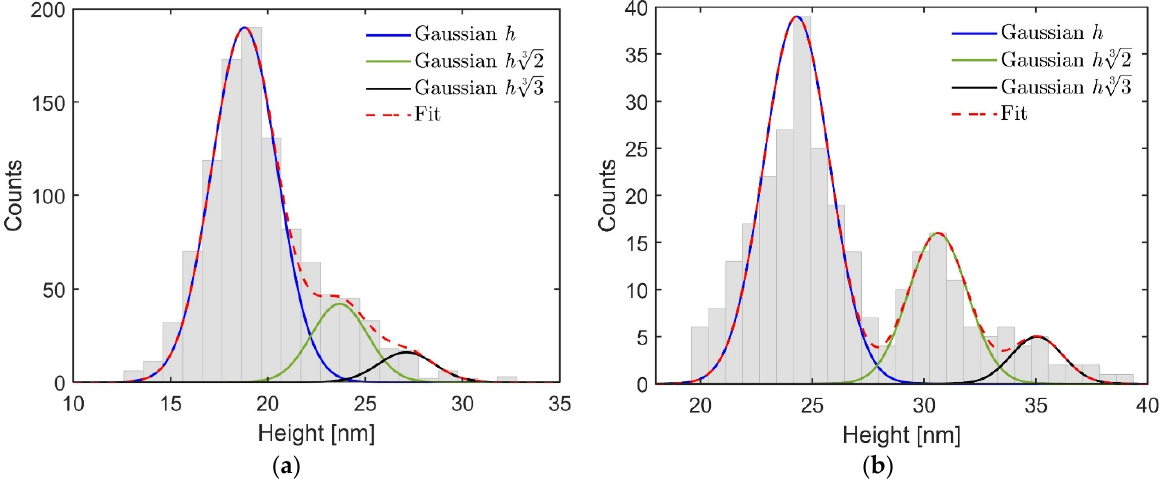
Figure 2. Cluster heights obtained by AFM for filtering at ( a ) low and ( b ) high potentials applied to EQMS. Gaussian distributions for the most abundant height h, corresponding to singly-charged particles, and those 3 2h, 3 3h, corresponding to doubly- and triply-charged particles, respectively, are present together with the overall one denoted as fit.